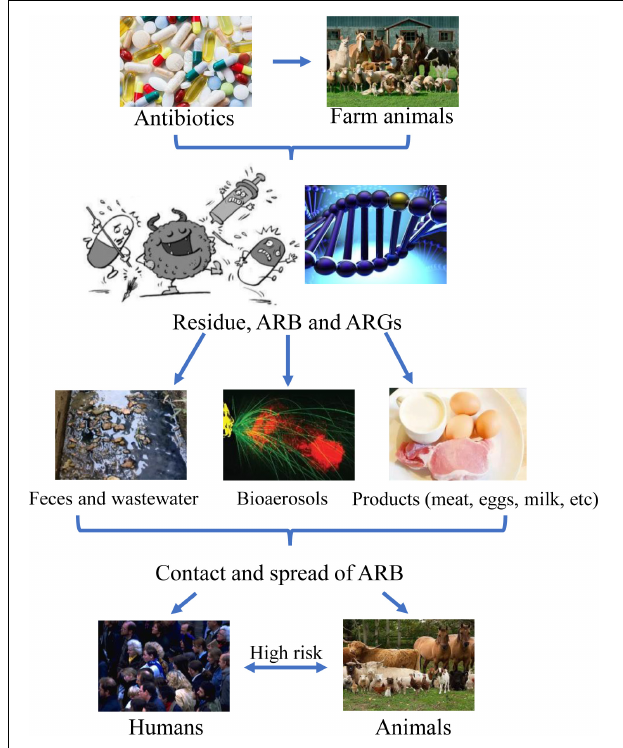
FIGURE 1 | Outlines of antibiotic resistance in food animal farms and